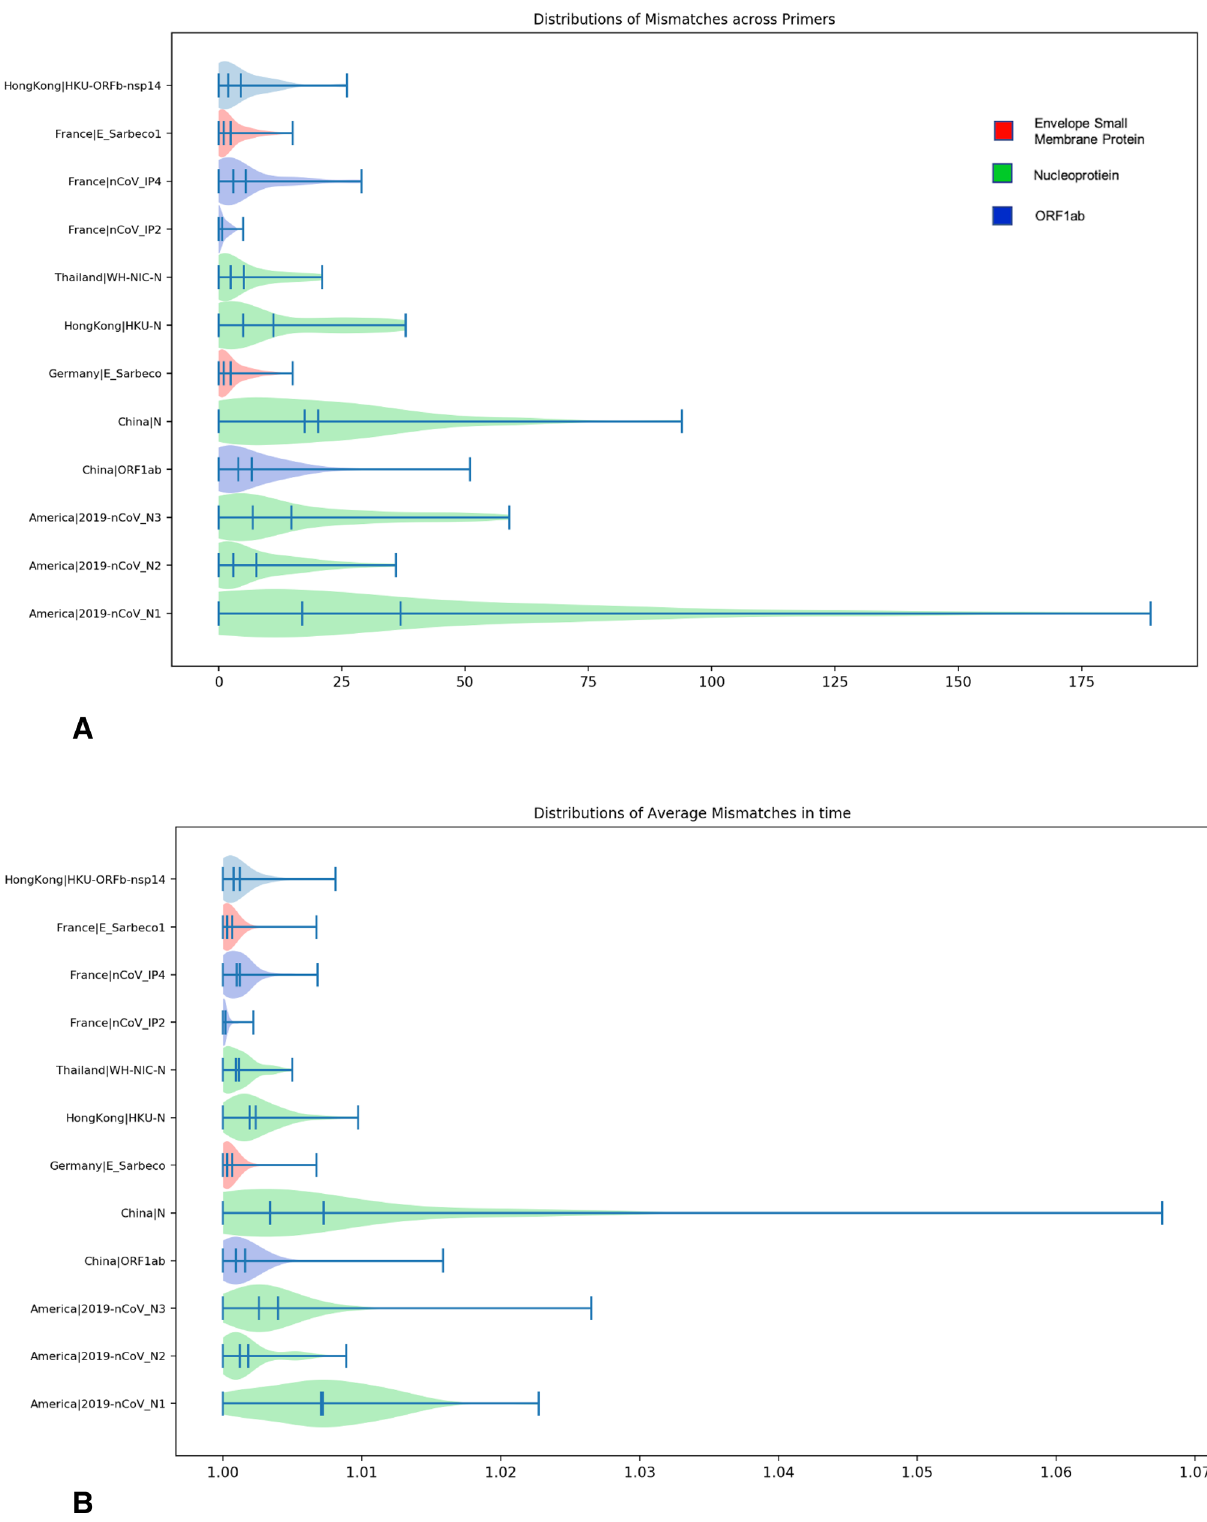
Figure 3. Distribution of mismatches for each primer. ( A ) shows the total number of mismatches aggregated for each day within the time range. ( B ) shows the number of mismatches for each day averaged by the number of genomes that occur on a day within the time